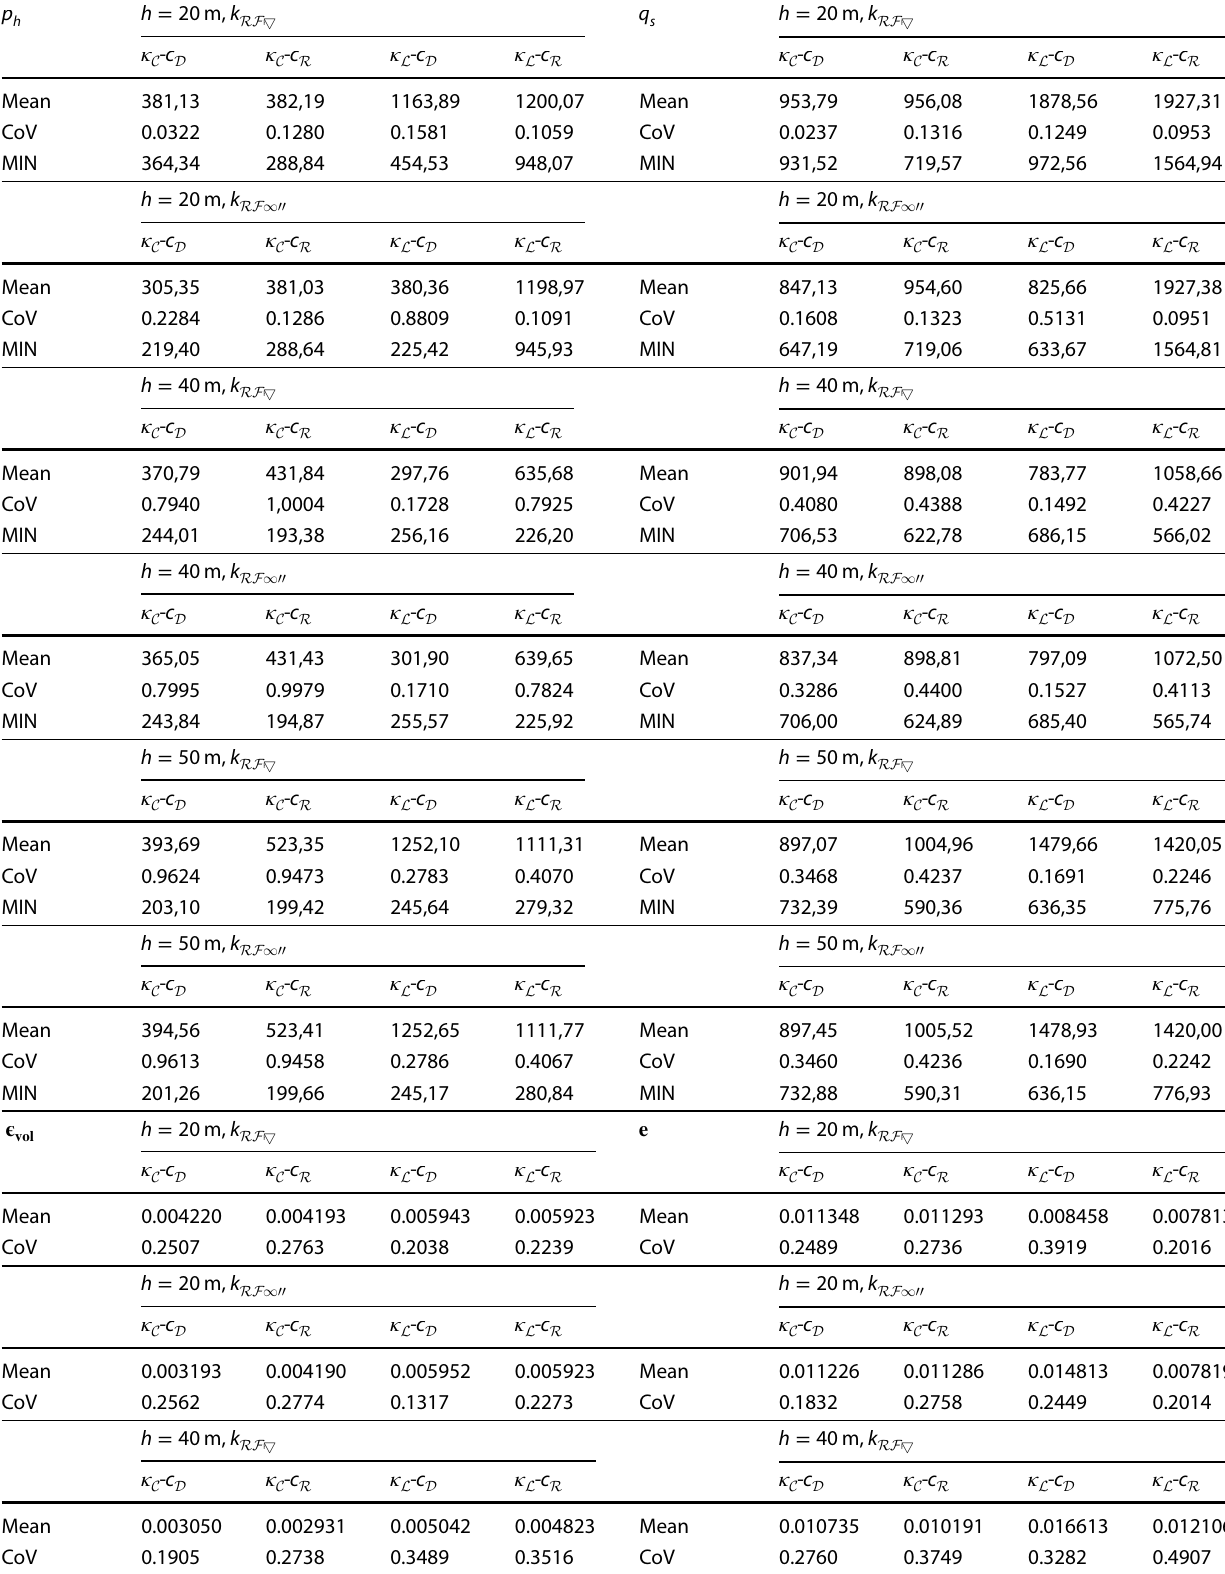
Table 10 Monte Carlo results for the stresses (KPa), the strains and the probability of the first Gauss point failure for porous analyses with linear and constant distribution for 𝜅 p